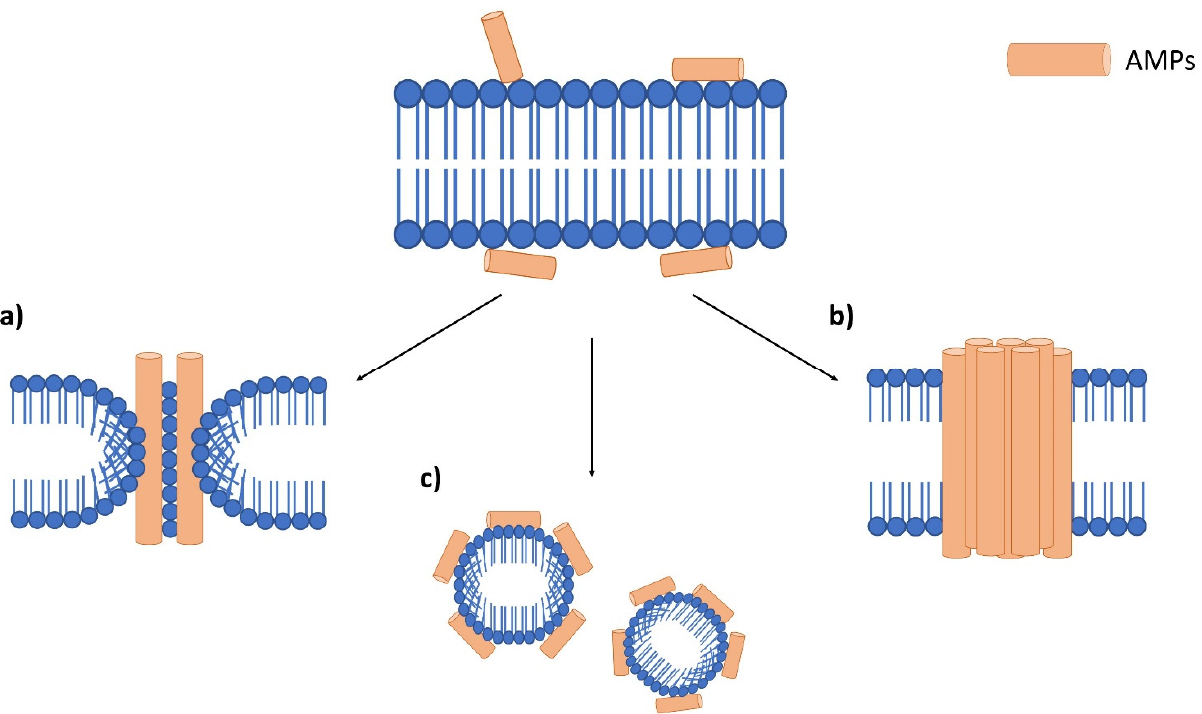
Figure 3. Antimicrobial peptide mechanism on the bacterial membrane. Accumulation of AMPs on the bacterial membrane surface, which leads to three main membranolytic mechanisms. ( a ) toroidal pore model which forms pores on the membrane, ( b ) barrel-stove model which AMPs aggregate before entering the membrane and ( c ) a carpet-like model which promotes the formation of micelles.